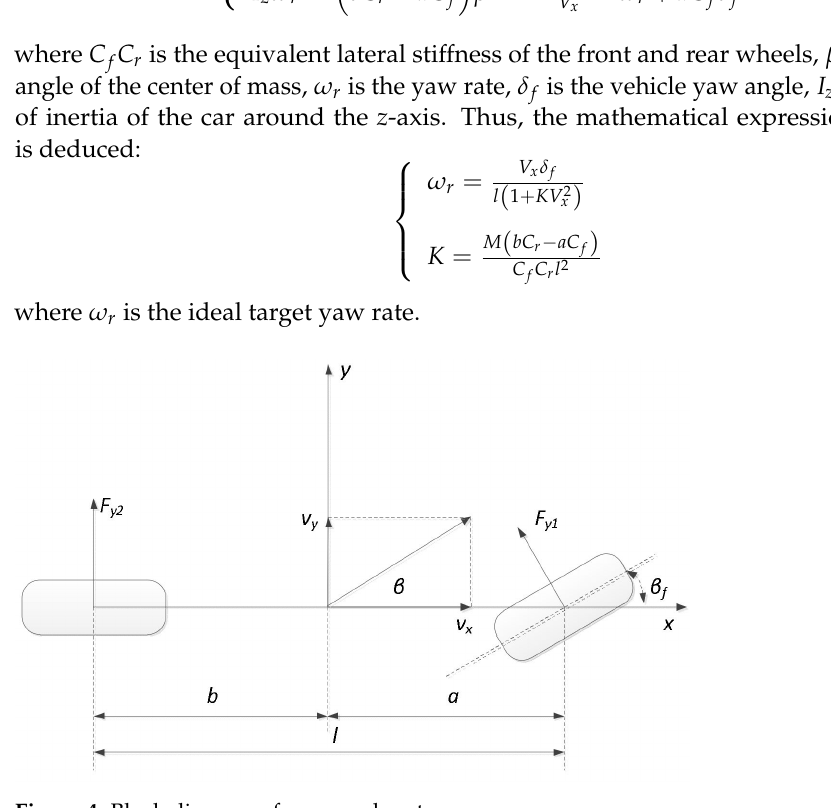
Figure 4. Block diagram of proposed